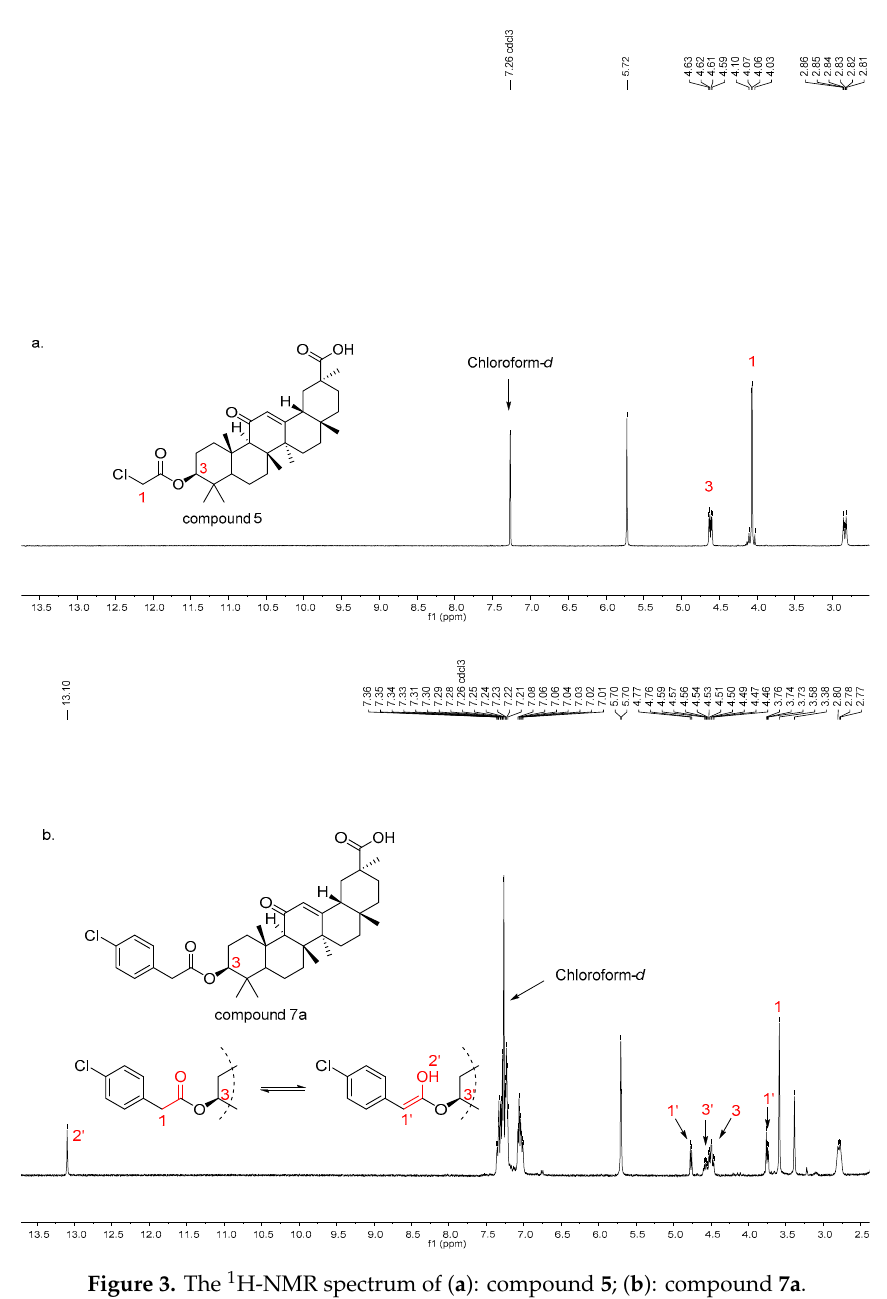
Figure 3. The 1 H-NMR spectrum of ( a ): compound 5 ; ( b ): compound 7a .